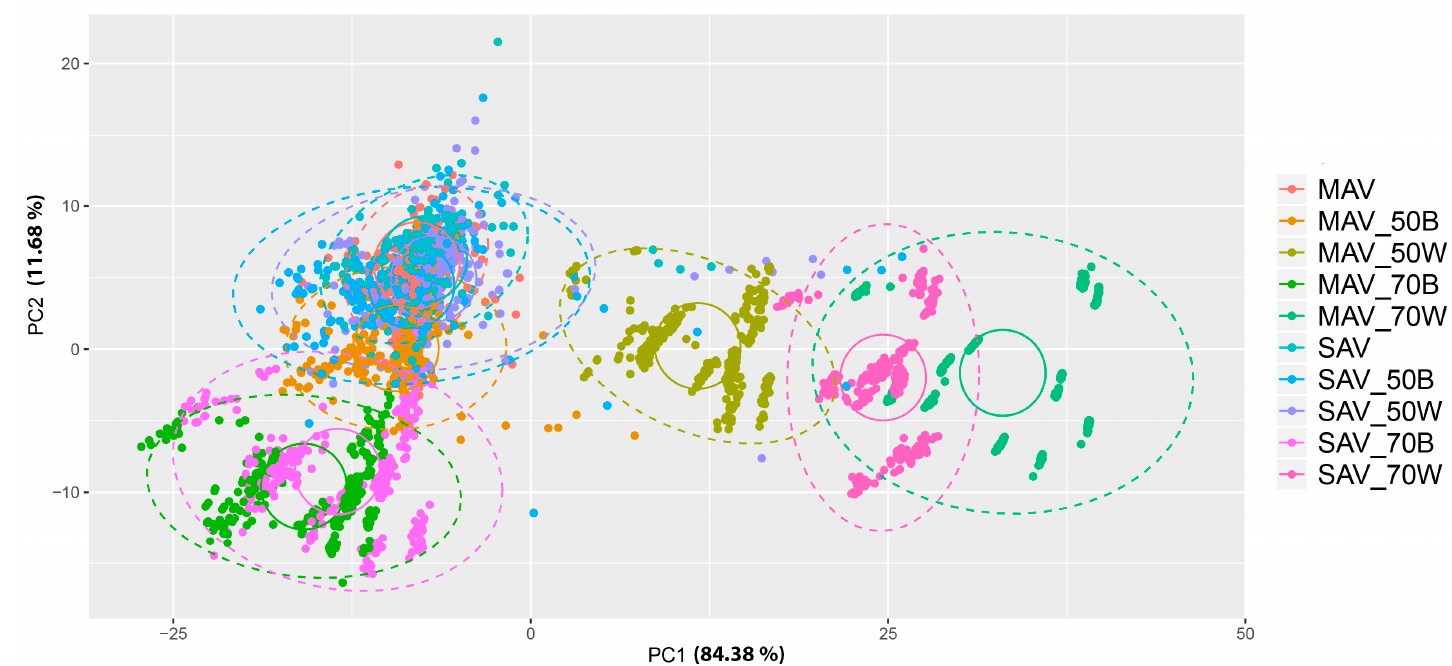
Figure 5. PCoA representing all the color measurements of the plants with and without adaptor. Ellipses around each type of adaptor indicate the dispersion of the measurements and circumferences encircle the centroids of the distributions of measurements of each adaptor type. Samples were colored according to the used adaptor. MAV, medium area view; SAV, small area view; 50B, 50% reduction with black adaptor; 50W, 50% reduction with white adaptor; 70B, 70% reduction with black adaptor; 70W, 70% reduction with white adaptor.